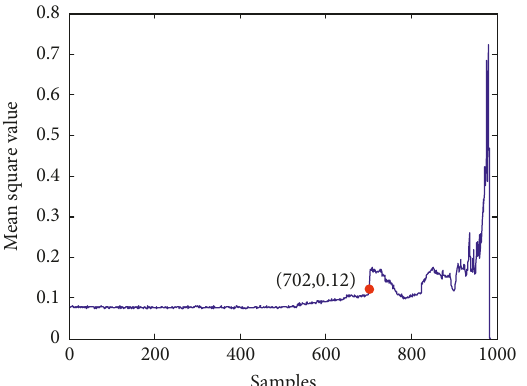
Figure 15: Root mean square value of bearing all life.